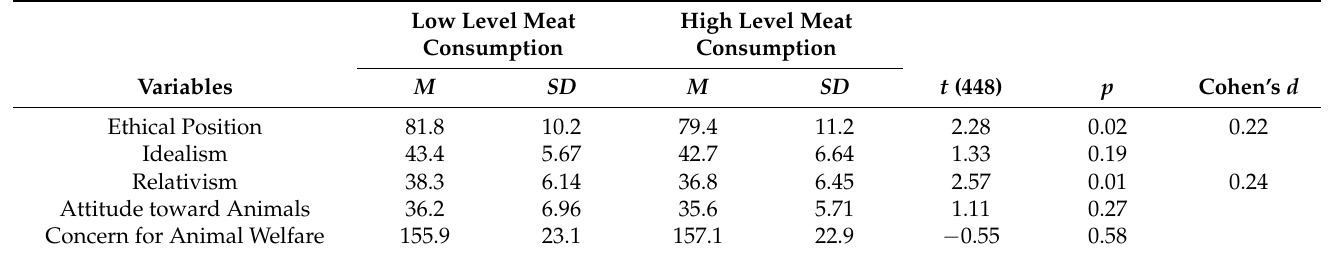
Table 4. Level of meat consumption along ethical position, relativism, idealism, attitude toward animals, and concern for animal welfare (N =